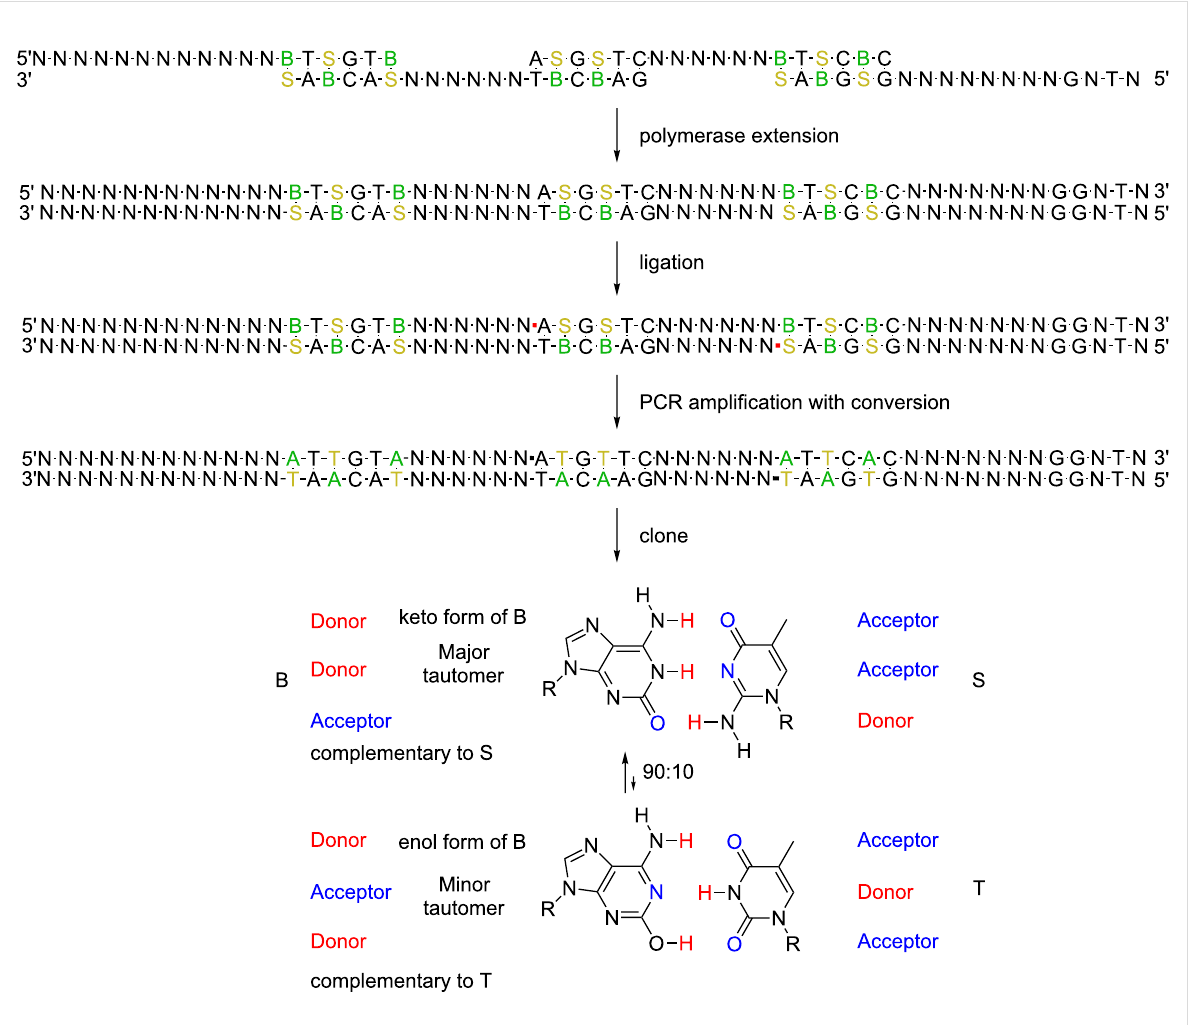
Figure 3: (top) Schematic showing the mix-anneal-extend-ligate-amplify process exploiting AEGIS pairing (to obtain clean assembly) followed by conversion to remove AEGIS pairs from the final construct. The process starts by mixing single-stranded DNA fragments designed to have their ends anneal as duplexes that include S : B pairs (note the colors). The higher information density enabled by the additional S : B pair lowers off-target hybridization, eliminates hairpins, and better guides the formation of the desired duplexes. After these duplexes are formed, the 3’-ends are extended using a polymerase that does not displace strands to give nicked DNA. Ligase then seals the nicks by forming the red bonds. Then, PCR amplifica- tion with conversion (shown here) or direct transformation into SEGUE TM replaces the S : B pairs in the construct by T:A pairs. (bottom) B in its major tautomeric form pairs with S ; in its minor tautomeric form, B pairs with standard T. This allows the AEGIS S : B pair to support the assembly of multiple single-stranded fragments using the mix-anneal-extend-ligate-amplify process, to be followed by conversion of the S : B pairs to T:A pairs after two cycles of PCR. In the conversion template B is replaced by standard A via an intermediate B :T mispairing, while template S is replaced by T via an intermediate S : B pairing followed by a second intermediate B :T mispairing.